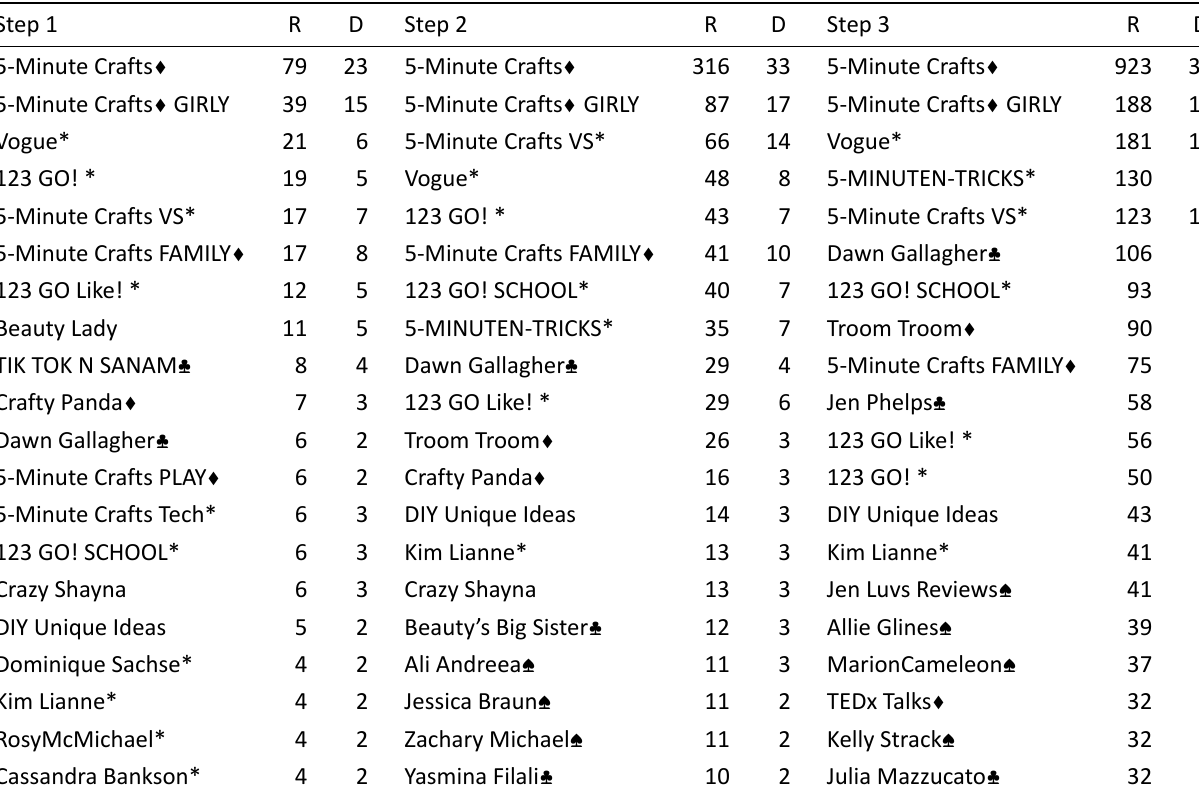
Table 5. Top 20 channels recommended for “beauty” at each